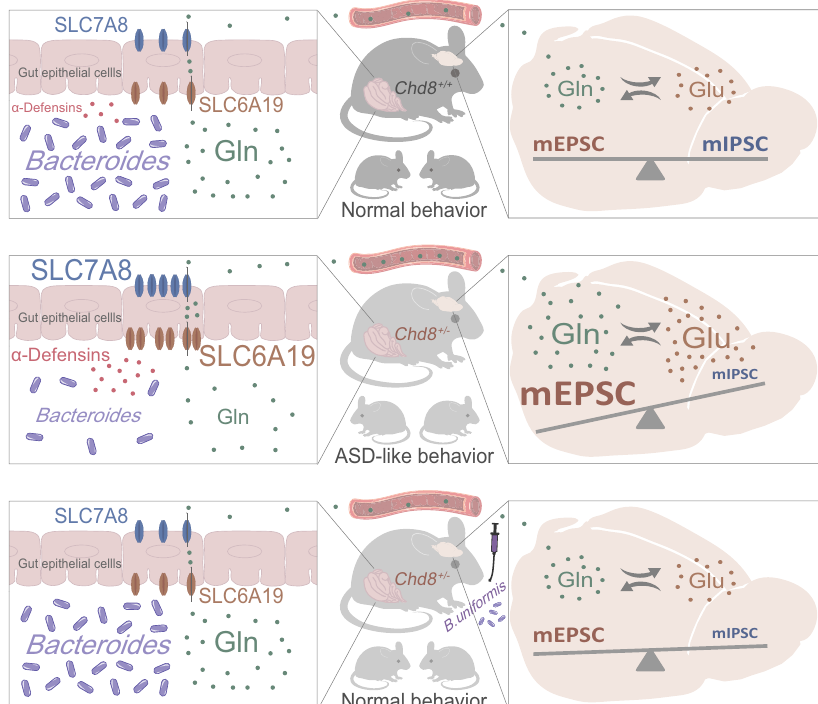
Fig. 7 Summary of the microbiota – gut – brain axis in the CHD8 mouse model of ASD. Chd8 + / − mice show increased expression of the intestinal transporters SLC6A19 and SLC7A8, resulting in more glutamine transported to the serum. Elevated serum glutamine increases the levels of glutamine and glutamate in the brain, contributing to the E/I imbalance and ASD-like behaviors in the Chd8 + / − mice. Gut microbiota dysbiosis characterized by a low abundance of Bacteroides in the Chd8 + / − mice is induced by high levels of intestinal α -defensins. In addition, supplementation with B. uniformis improves the E/I imbalance and restores ASD-like behaviors in the Chd8 + / − mice by decreasing the intestinal amino acid transport of glutamine and thus reducing the glutamine and glutamate levels in the